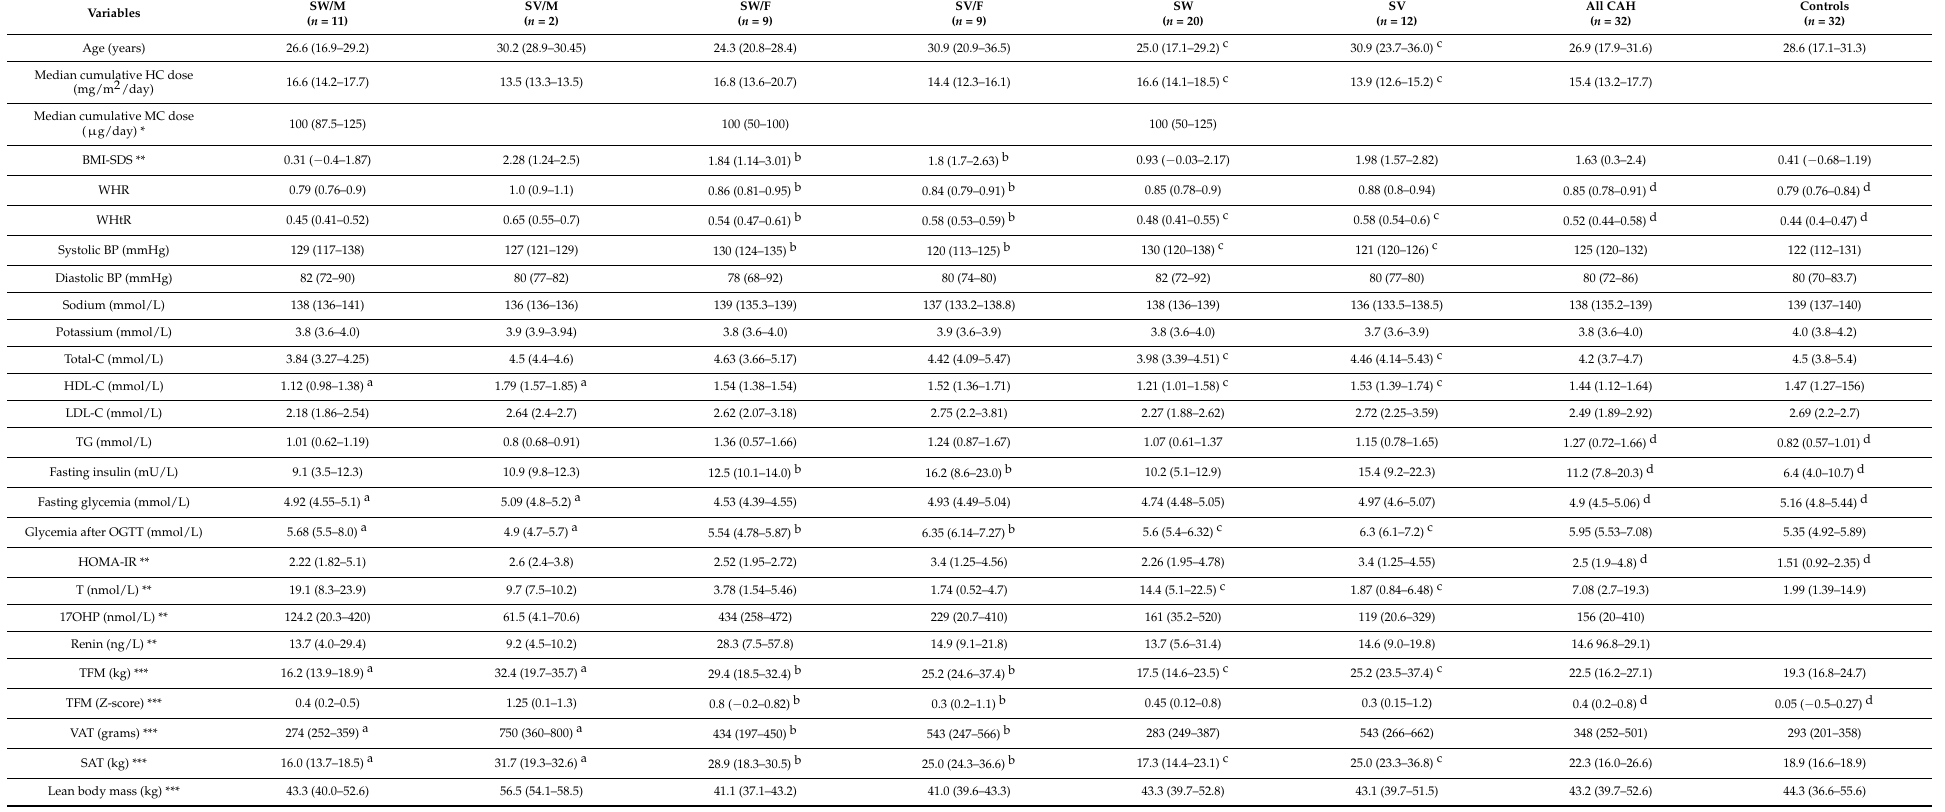
Table 2. Clinical characteristics of the CAH patients and matched